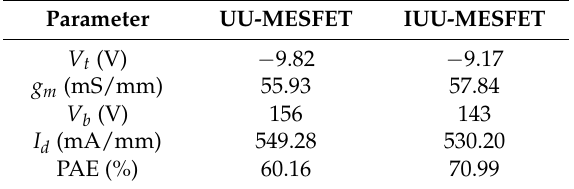
Table 1. Comparison of structural parameters for the two